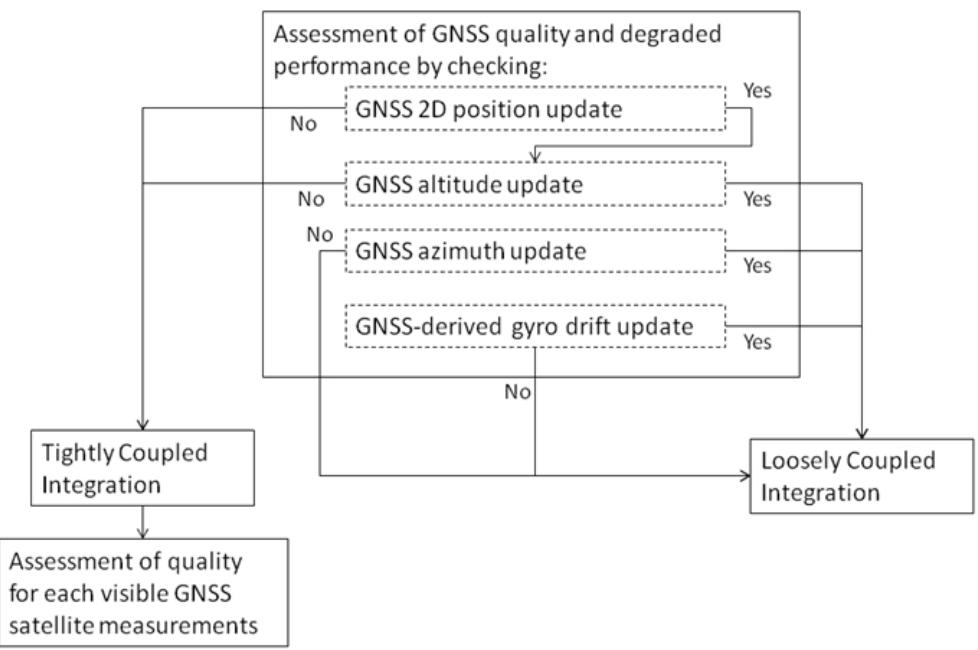
Figure 1. Diagram of the GNSS assessment and hybrid loosely/tightly coupled scheme